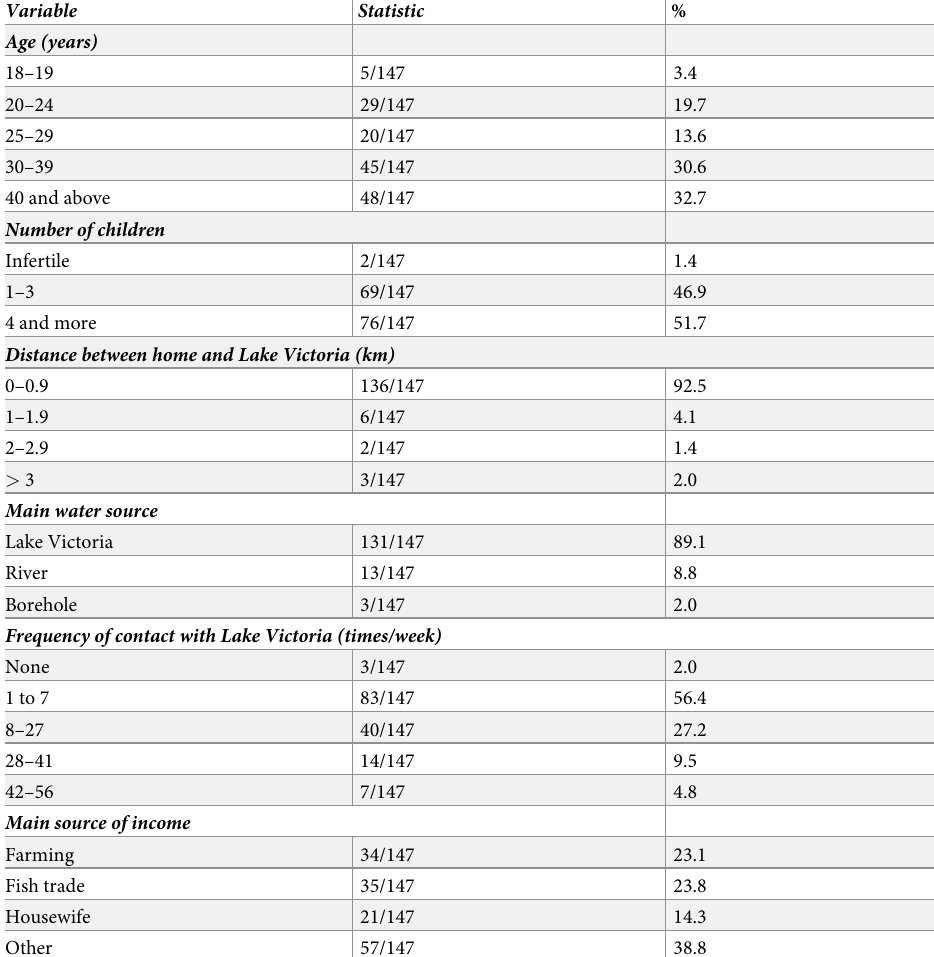
Table 1. Characteristics of 147 women in Schistosoma mansoni endemic villages near Lake Victoria, Kenya.